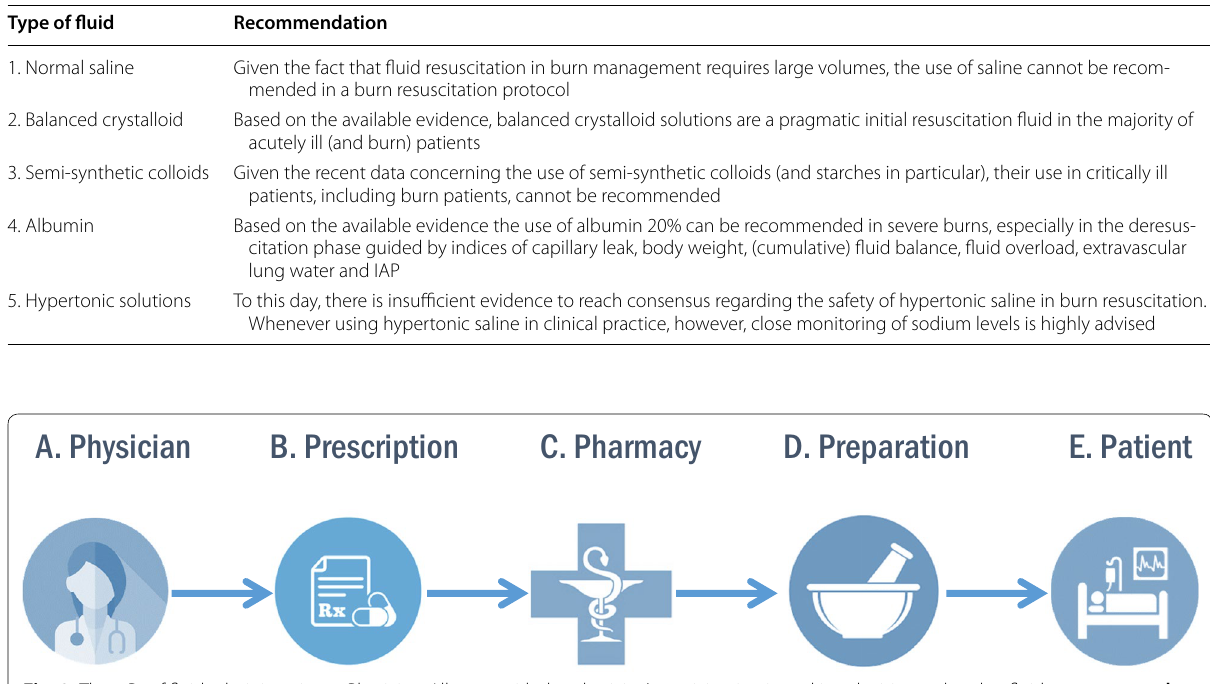
Table 4 Recommendations regarding fluid resuscitation in severe burns’ patients. Adapted from Peeters et al. [106] with permission